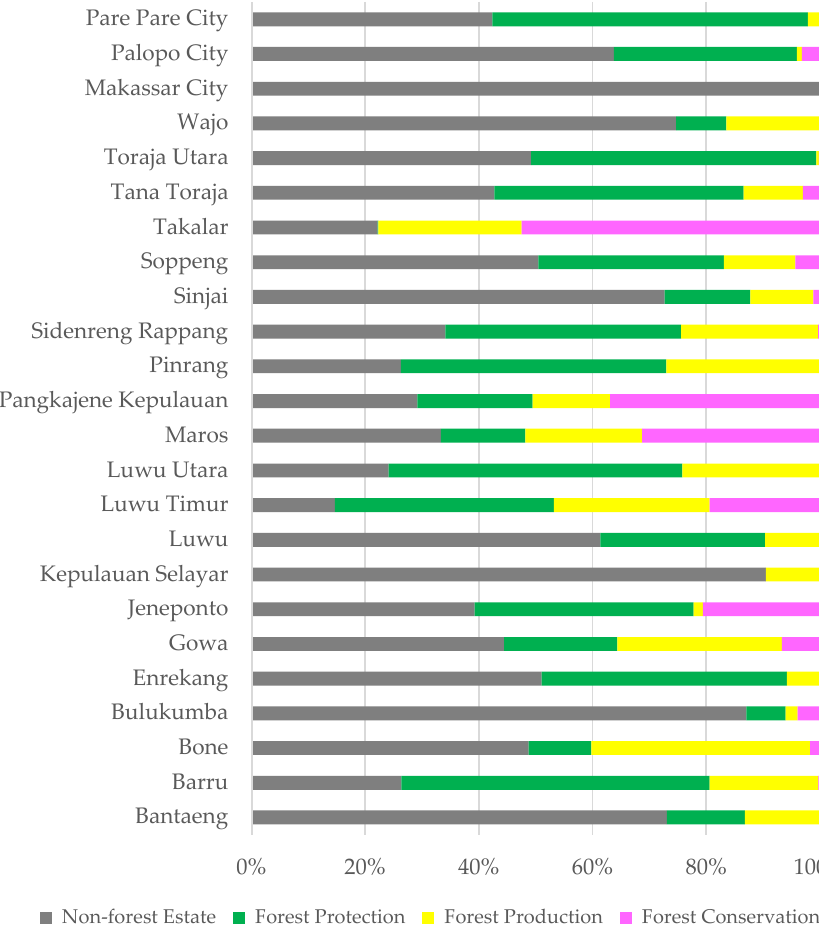
Figure 6. Percentage of Forest Area in Designated Forest Areas.